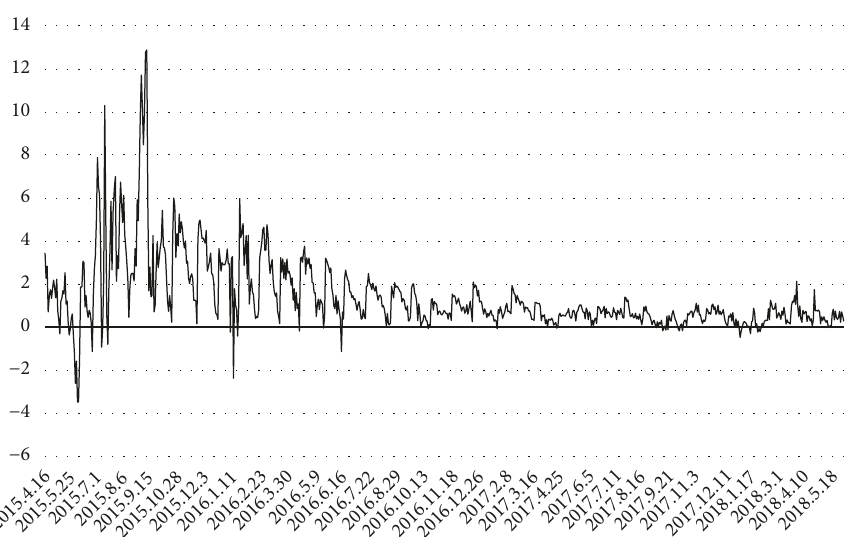
Figure 4: The basis sequence of CSI 500 stock index